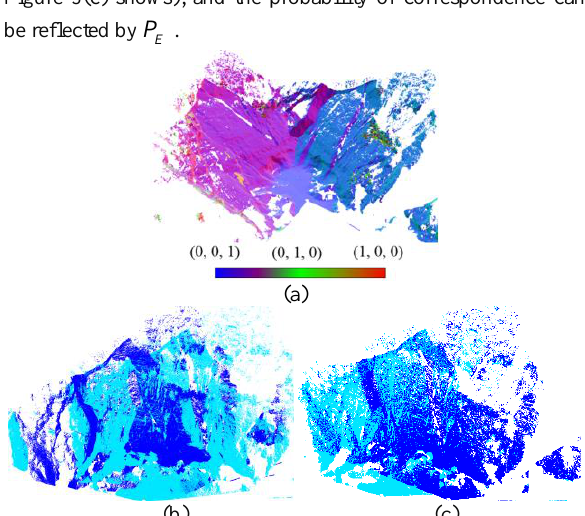
Figure 3. Registration results by original model and the proposed model: (a) Rendering results by normal vectors of two stations. (b) Registration result by the original model. (c) Registration result by the proposed model.